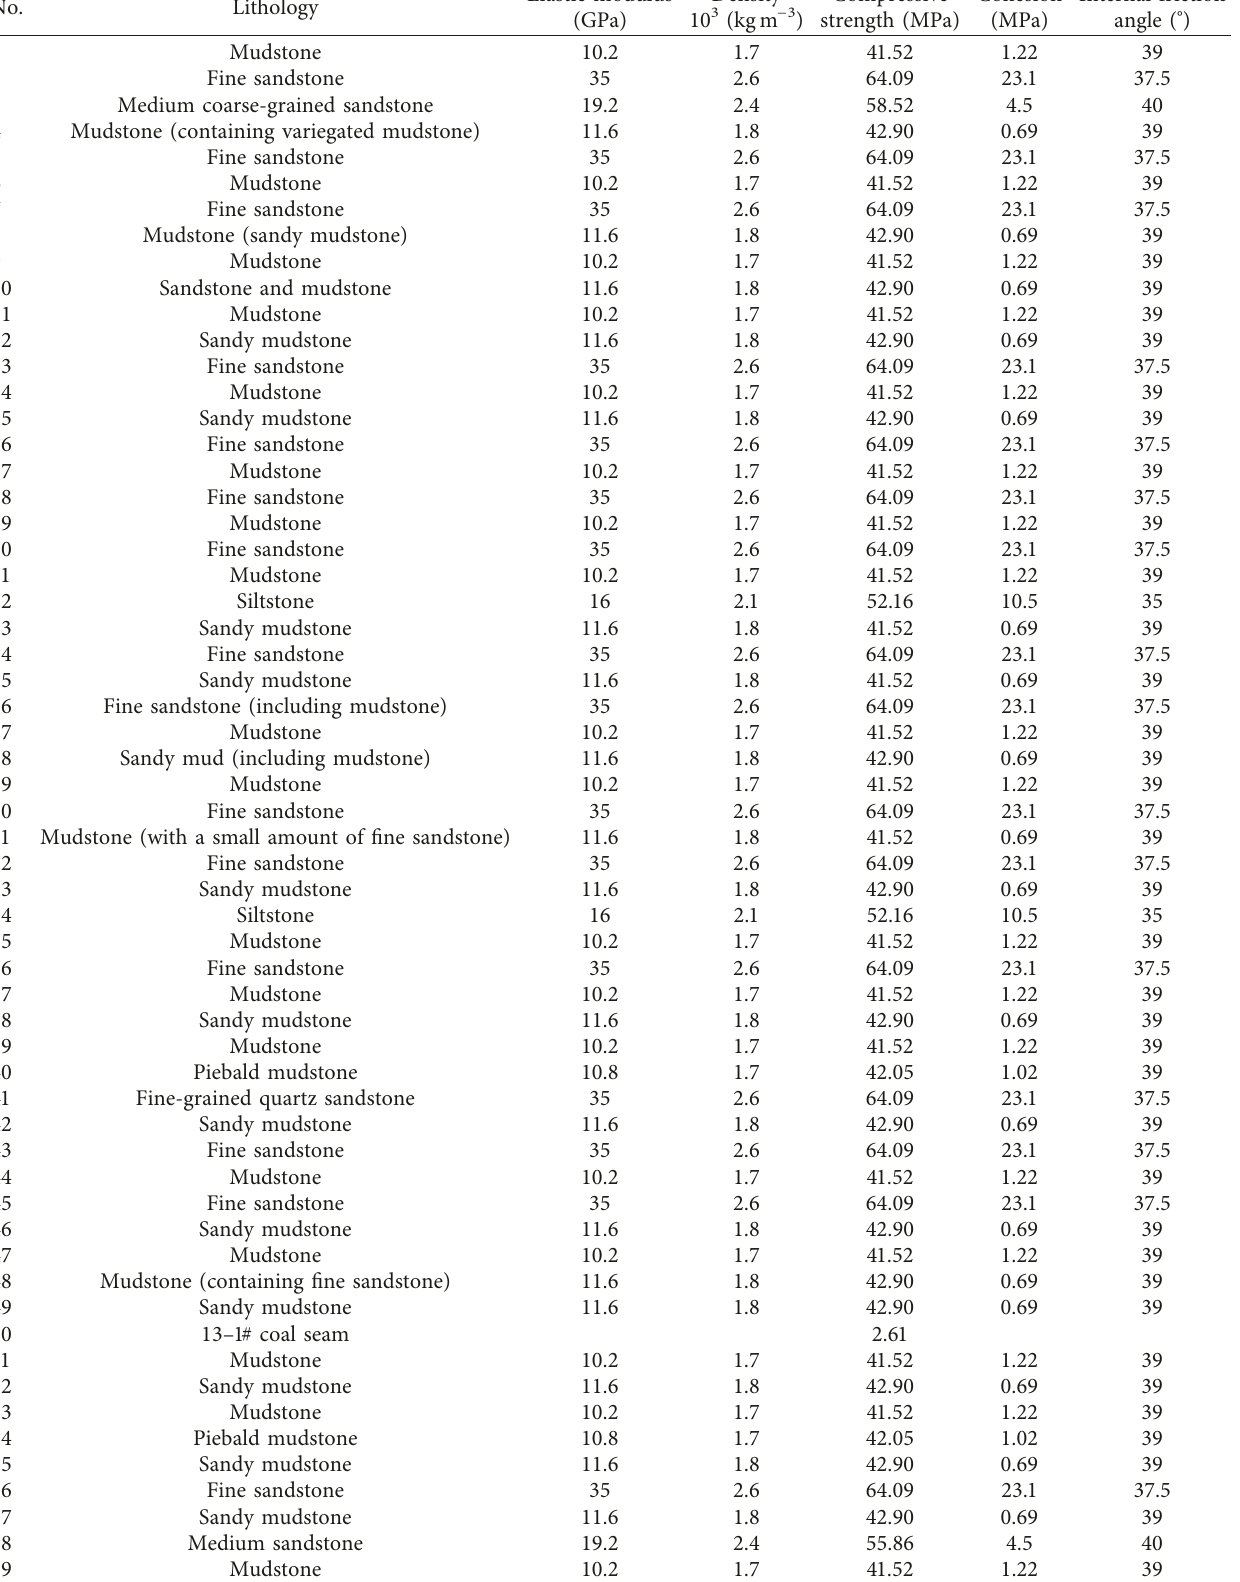
Table 1: Mechanical parameters of coal and rock mass by similar